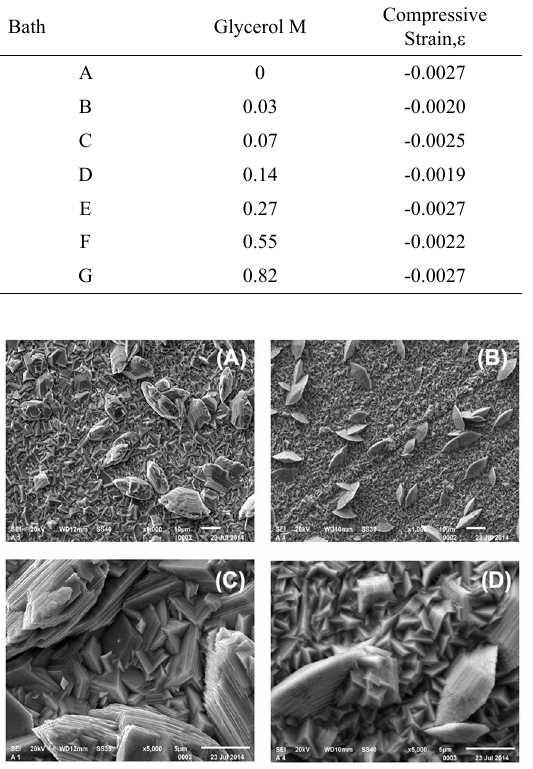
Figure 6. SEM of zinc electroplated steel AISI 1020. (A) micrograph of Zn coating obtained from a electrodeposition bath containing no glycerol at 1000X, (B) containing 0.82 M glycerol at 1000X, (C) free glycerol at 5000X and (D) containing 0.82 M glycerol at 5000X The micrographs indicate that glycerol has an effect on the morphology of zinc. It is observed that in the absence of glycerol, larger grains formed that were irregular in size and shape, both on the innermost layer as well as the uppermost layer. Upon the addition of glycerol, grains of more regular size and geometry are formed.